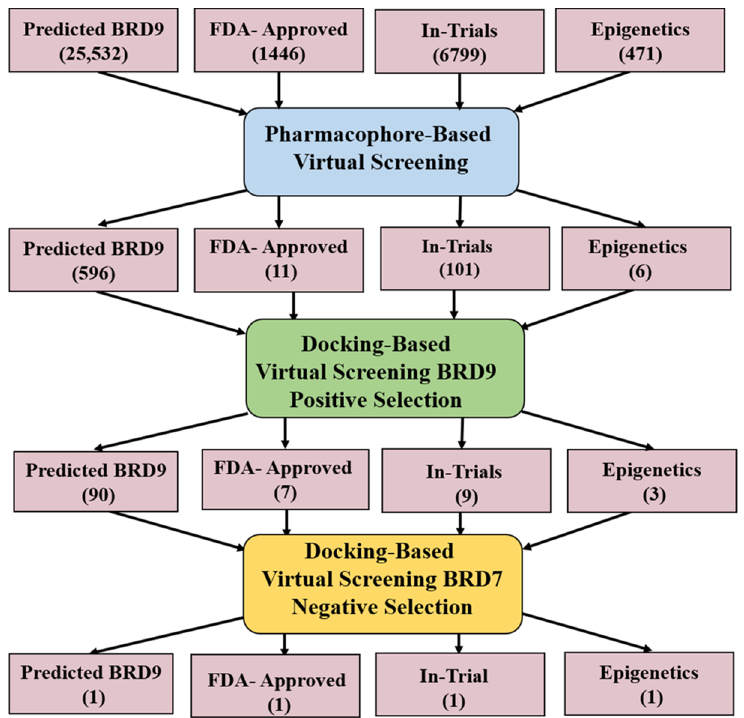
Table 3. Summary of the four shortlisted compounds with binding energy